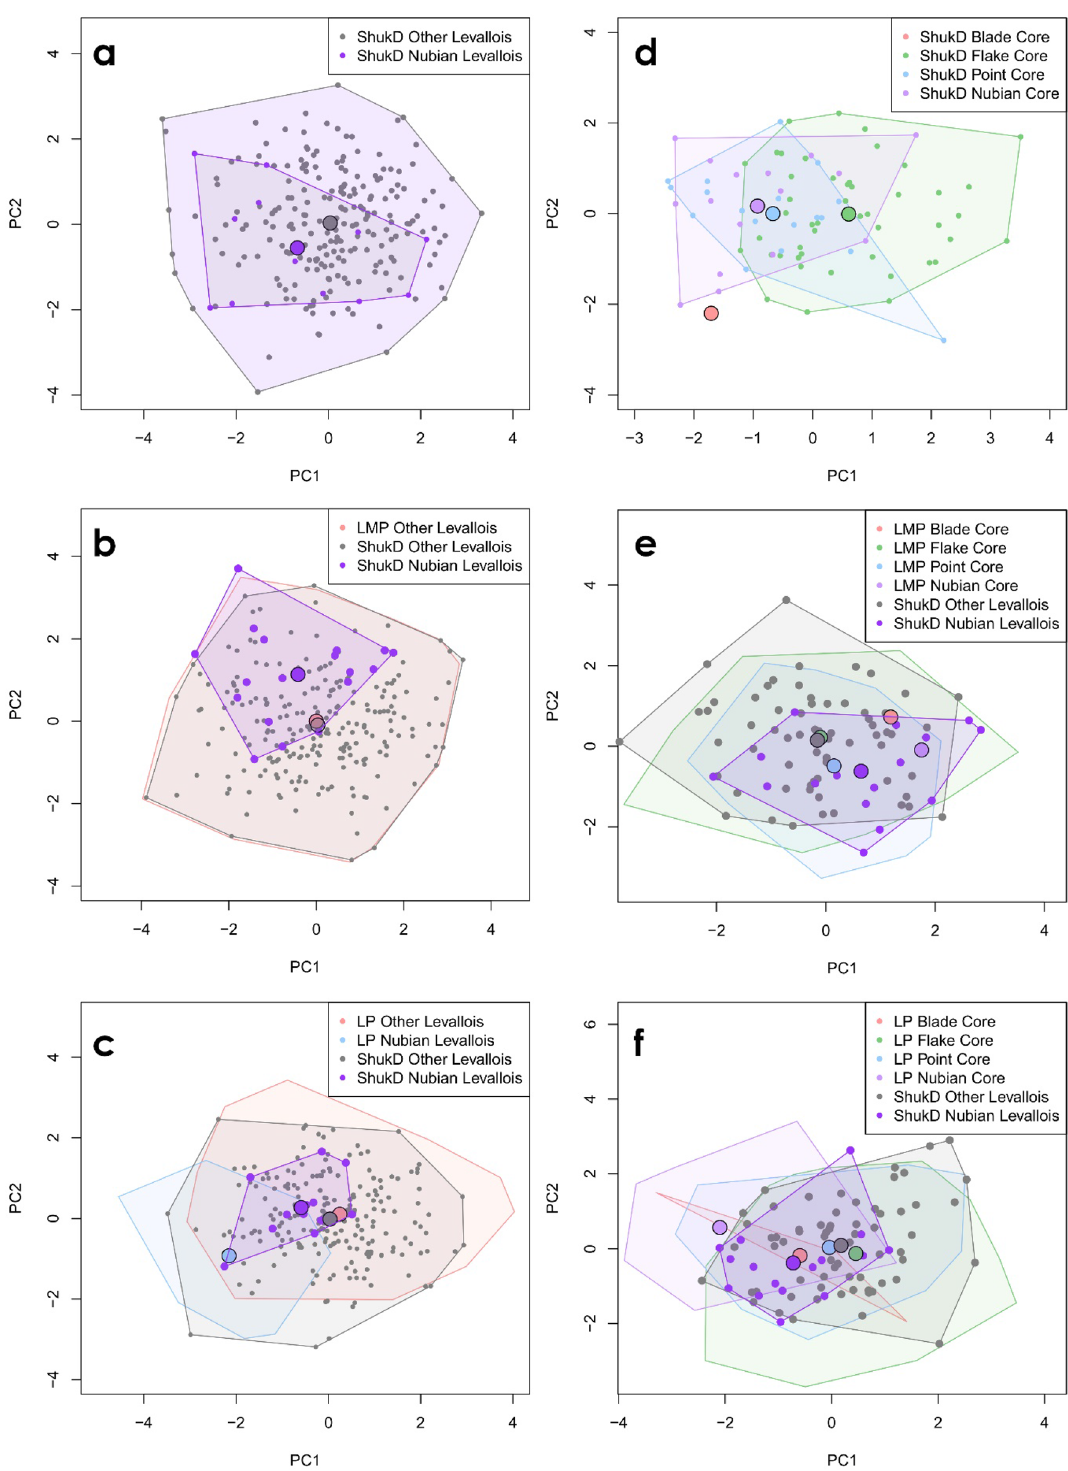
Figure 6. PCA biplots of from comparison of Nubian Levallois points and other Levallois Points (left), and Nubian Levallois cores and other Levallois cores (right): ( a , d ) Nubian Levallois points and cores from Shukbah fall within variability observed across the wider body of Levallois points and cores; ( b , e ) the Shukbah point and core assemblage show considerable comparability to other late Middle Palaeolithic (LMP) datasets (dated to MIS 4/3 and/or associated with Neanderthals), including Nubian Levallois specimens which fall within the range of morphological variability observed. ( c , f ) the Shukbah point and core assemblage, including Nubian Levallois points and cores, show considerable comparability to other Late Pleistocene (MIS 5–3) Middle Palaeolithic Levallois Points and Cores, whereas Nubian Levallois points and cores from other Late Pleistocene Middle Palaeolithic sites typically exhibit distinct differences in artefact